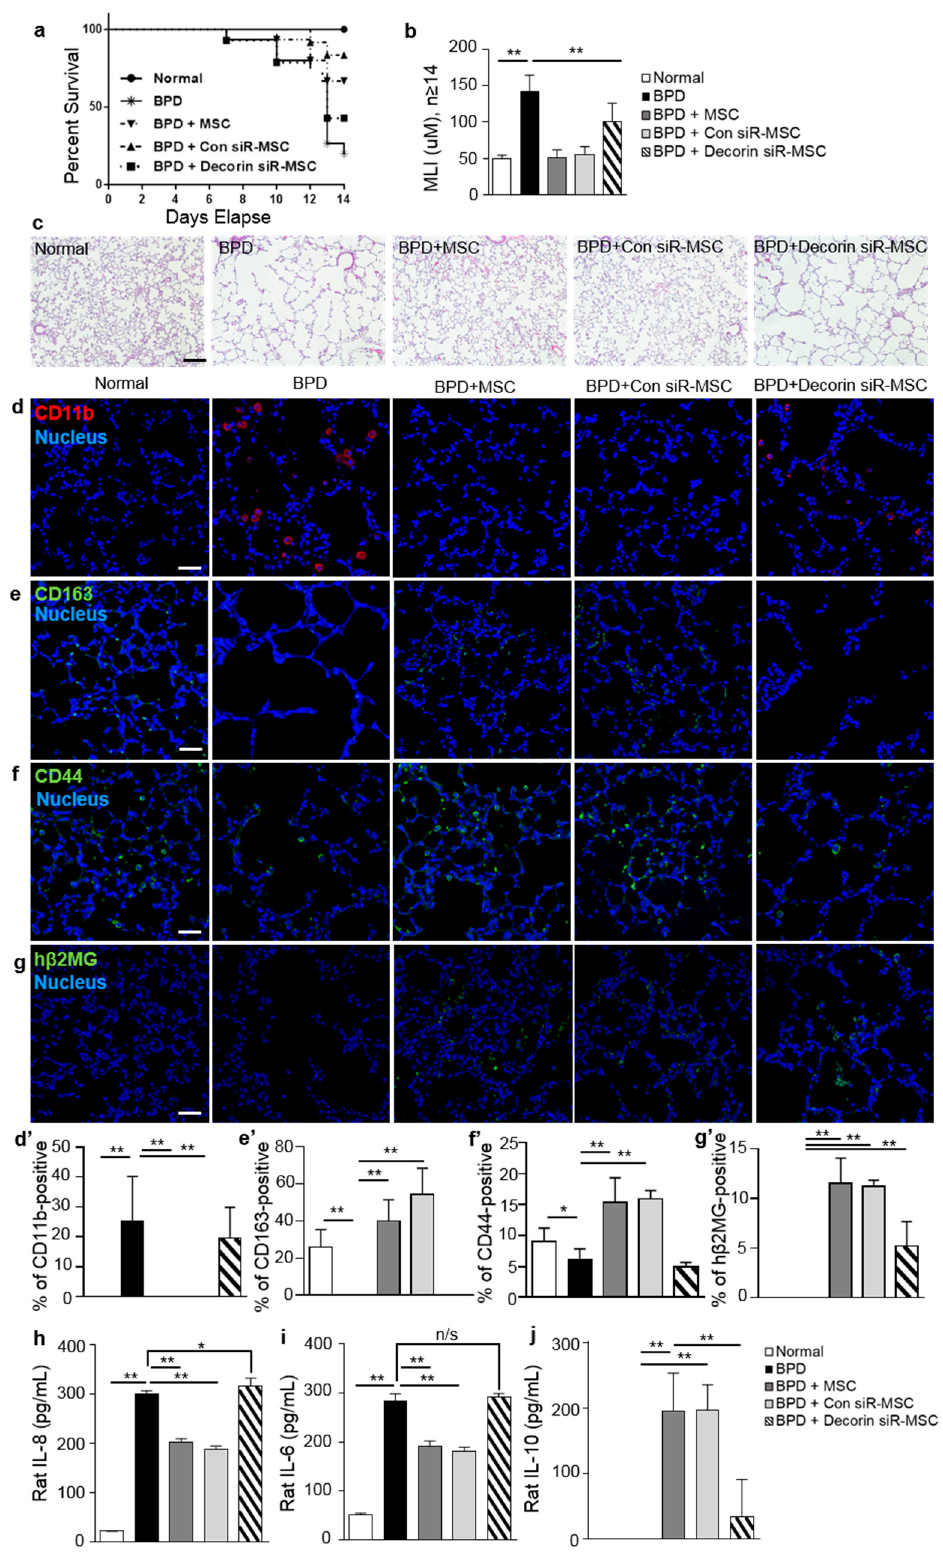
Figure 5. Decorin knockdown suppressed the therapeutic effects of MSCs by down-regulating macrophage polarization. Decorin-silenced MSCs were intratracheally injected in BPD rats. ( a ) Decorin siRNA-transfected MSCs were intratracheally injected on day 5. Daily survival rates during